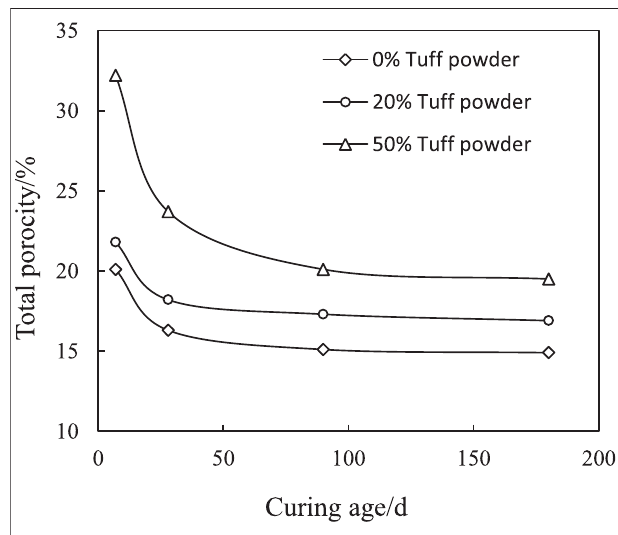
FIGURE 7 | The total porosity of tuff powder-cement hardened paste at different curing ages.